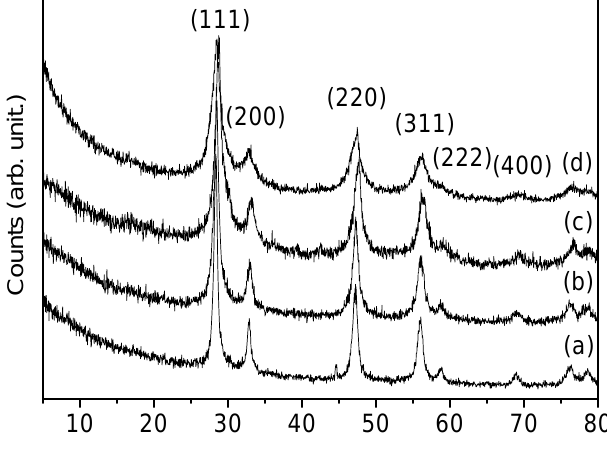
Figure 1. Powder XRD patterns of (a) CeNR, (b) CeNR-PhEt-BuOOH, (c) CeNR-BuOOH and (d) CeNR-H O 2 2